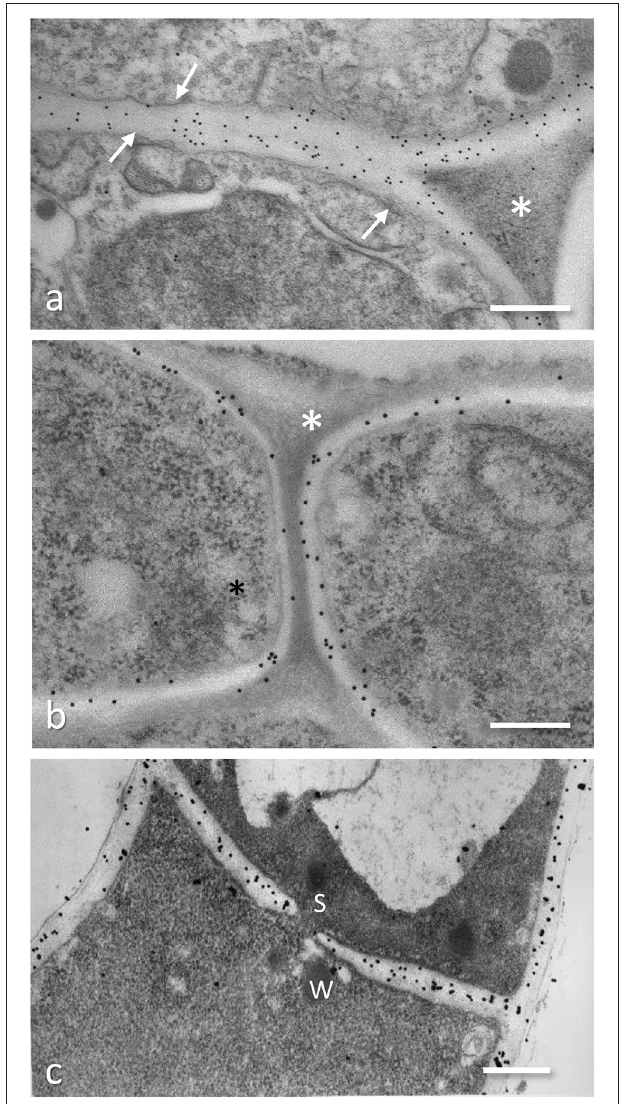
FIGURE 4 | Immunogold localization of fungal cell wall components on ultrathin sections of specimen fixed and embedded following the protocol 2 in the Appendix. (a,b) Localization of β -1,3-glucans on Tuber melanosporum fruiting body hyphae and on the interface Tuber melanosporum - Corylus avellana ectomycorrhizae: 20nm gold granules are present on the fungal cell wall (arrows). In ectomycorrhizae (b) , the fungal cell wall is labeled in both the mantle hyphae (D) and in the hyphae progressing between the root cells during the Hartig net establishment (E). No gold granules are present on the electron-dense material with a triangle shape that fills the space among the hyphae (asterisk). Bar, 0.3 µ m. (c) Localization of chitosan on cell wall and septum (S) of Blumeria graminis f.sp. hordei by a chitosanase-20nm gold probe; courtesy of D. Maffi. Bar, 0.5 µ